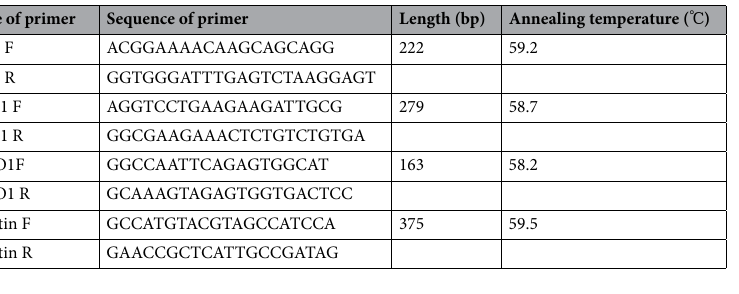
Table 3. Primers